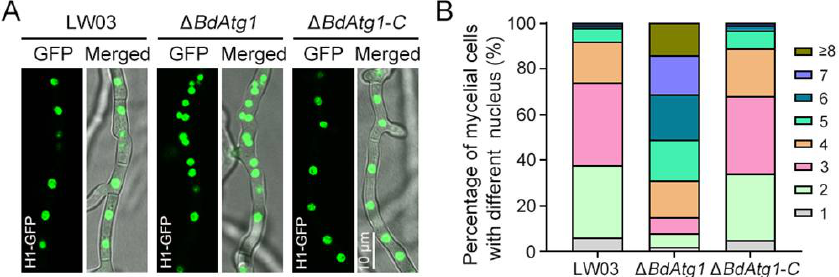
Figure 7. BdAtg1 mediates nuclei distribution. ( A ) Nuclei distribution in mycelia of B. dothidea strains. ( B ) The number of nuclei in mycelial compartment of each strain.